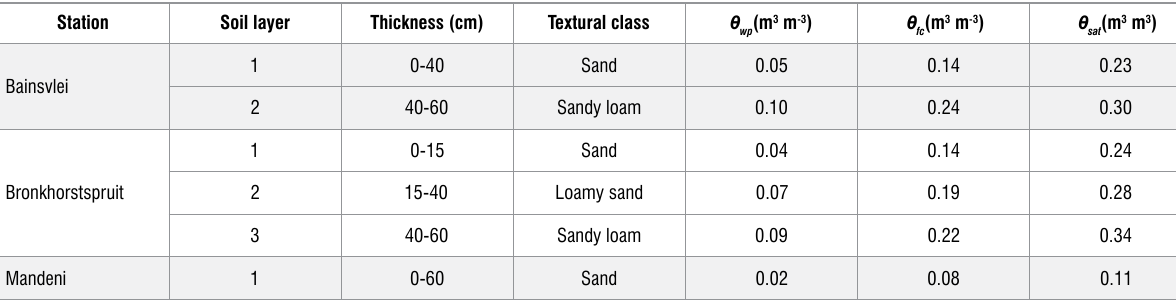
Characteristics of soil layers at all stations